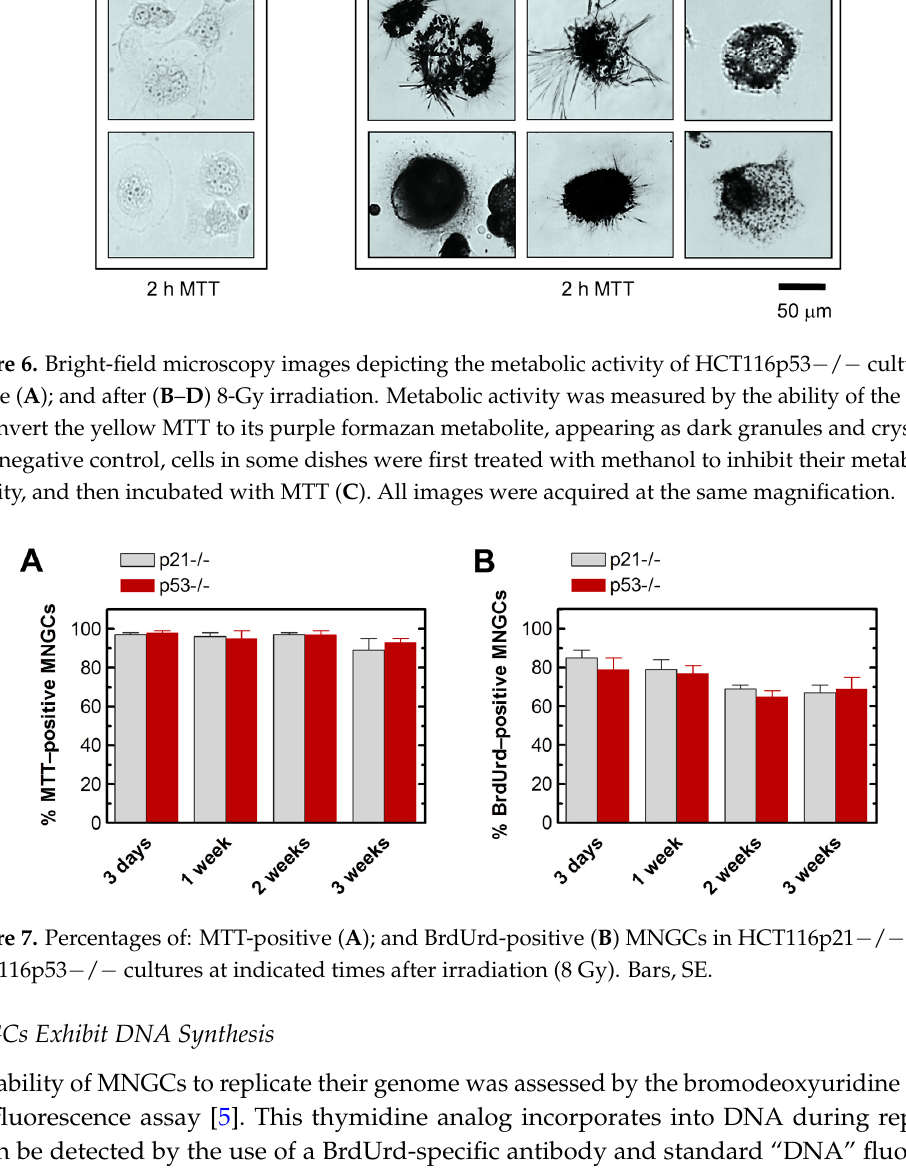
Figure 8. Representative images showing proliferating cells (BrdUrd-positive; green) and total cells (DAPI; blue) in HCT116p53 − / − cultures acquired before and three days after irradiation. In all experiments, BrdUrd was added to the culture medium for the final 24 h of the incubation period to allow its incorporation into genomic DNA. Arrows show some cells that did not incorporate BrdUrd under these conditions. All images were acquired at the same magnification.